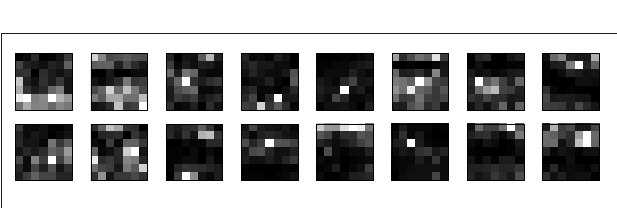
Figure 25 | receptive fields weight distribution of memristor conductances after training for one patch out of 324 of one epoch, obtained through spectre circuit